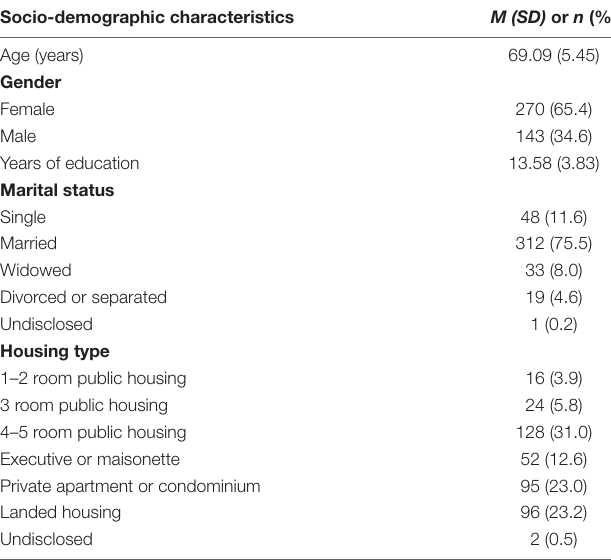
TABLE 1 | Socio-demographic characteristics of the sample ( N = 413). Socio-demographic